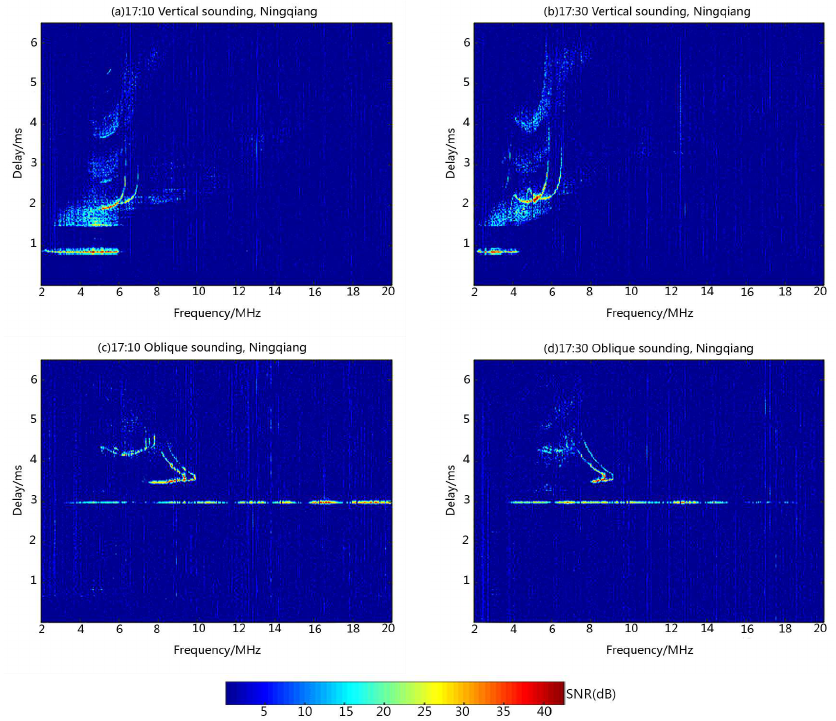
Figure 7. Multi-station sounding experiment using complete complementary code: Vertical sounding ionogram at ( a ) 17:10, and ( b ) 17:30; Oblique sounding ionogram at ( c ) 17:10, and ( d ) 17:30.